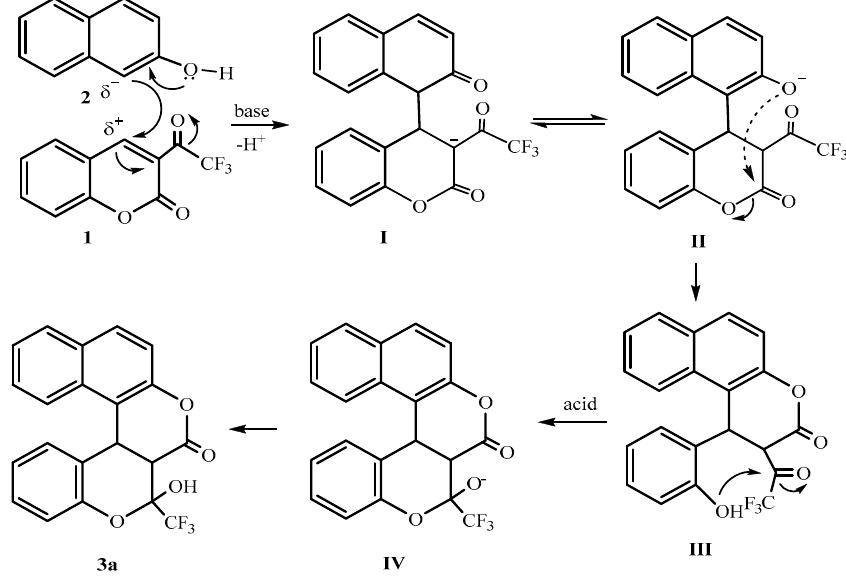
Scheme 4. Plausible mechanism for compound